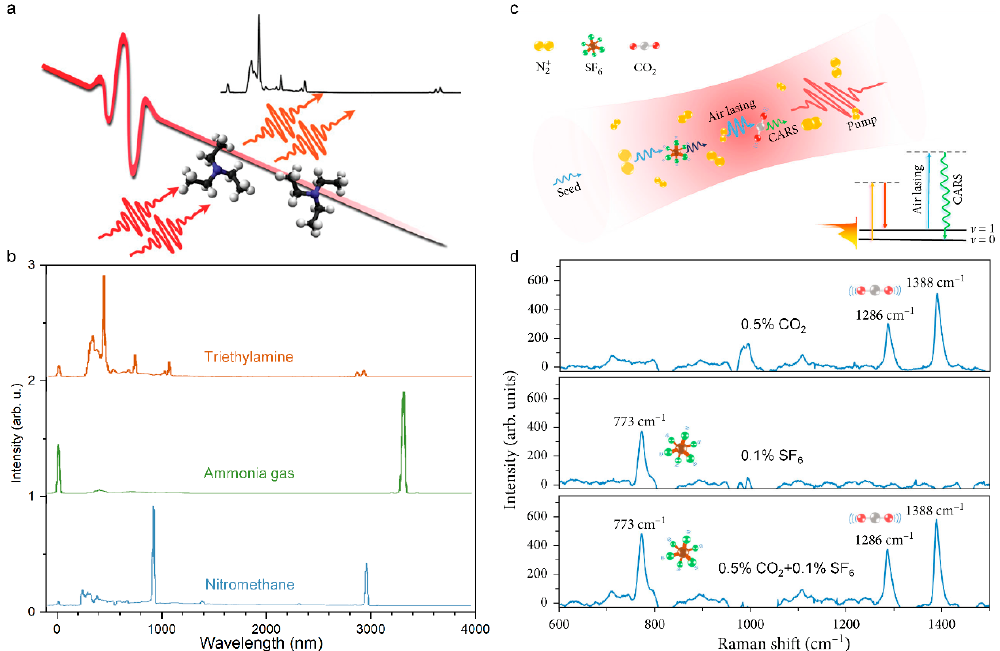
Figure 14. Filament-driven impulsive Raman spectroscopy. ( a ) Schematic diagram of filament-driven impulsive Raman spectroscopy. ( b ) Raman spectra of triethylamine, ammonia gas, and nitromethane that was measured using filament-assisted impulsive Raman spectroscopy [220]. ( c ) Schematic diagram of the basic principle for the greenhouse gas detection with air-lasing-based Raman spectroscopy. CARS, coherent anti-Stokes Raman scattering. ( d ) CARS spectra that was measured in the mixture of standard air and 0.5% CO 2 , 0.1% SF 6 , 0.5% CO 2 , and 0.1% SF 6 [225].